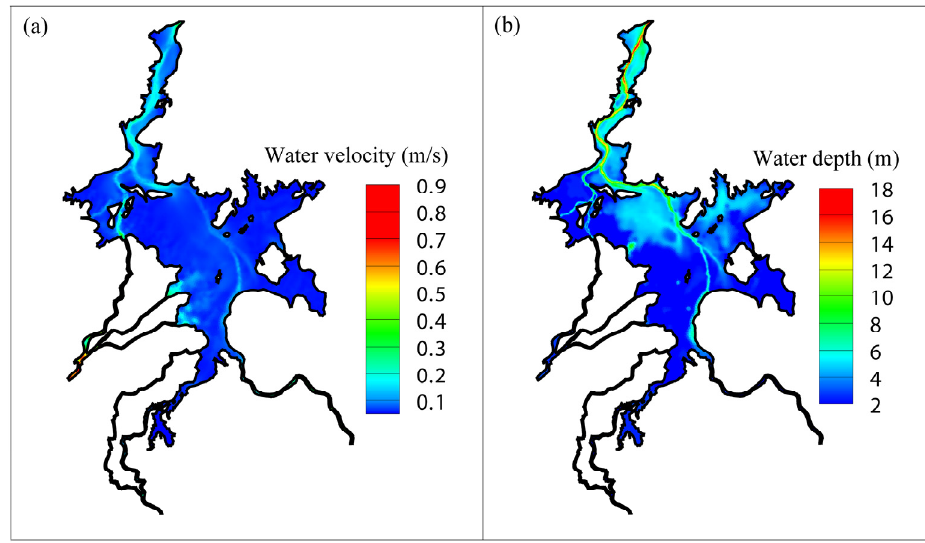
Figure 2. ( a ) Spatial distribution of water velocities and ( b ) corresponded water depths averaged over the flood period (July–September) of MIKE 21